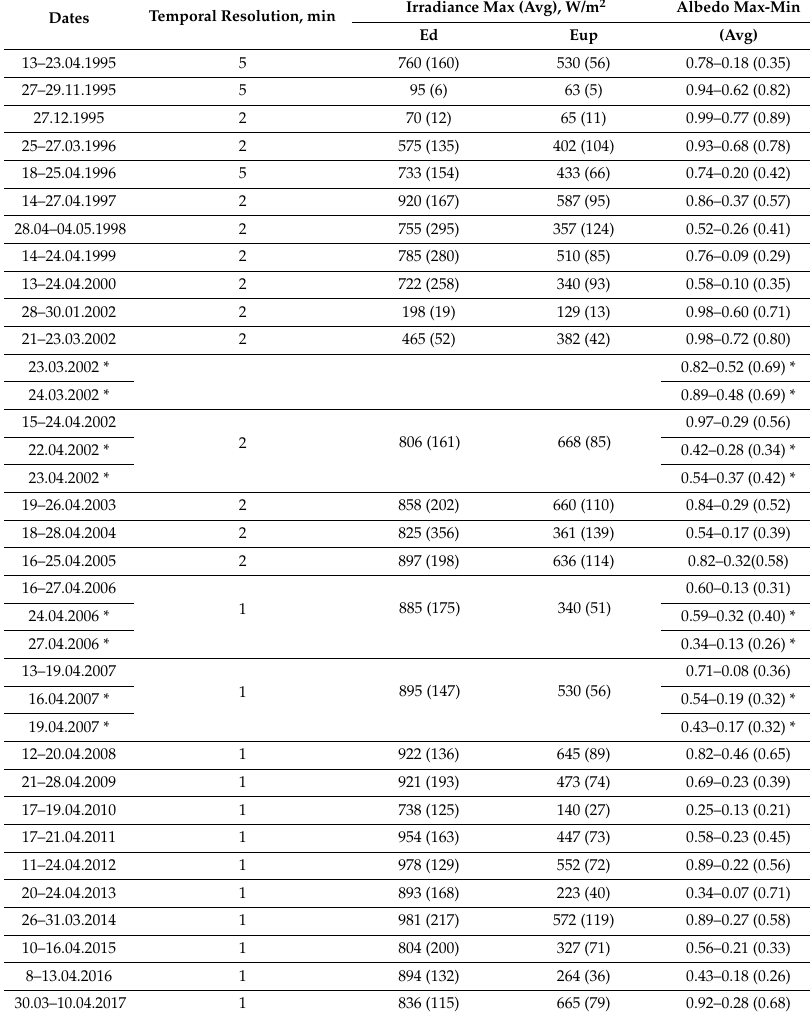
Table 1. The dates and the temporal resolution of measurements of irradiance (downwelling Ed and upwelling Eup, maximal and average values) and albedo (maximal, minimal and average values) at the radiation station over the whole measurement period in different years. * Dates of spatial measurements of albedo and its maximal, minimal and average across all stations of both